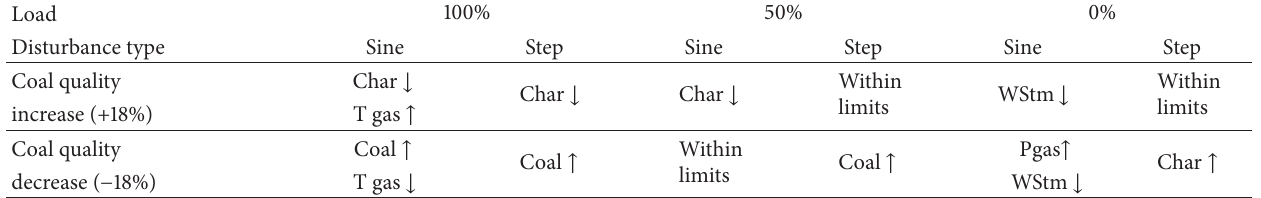
Table 7: Violation variables under coal quality change ( ± 18%) ( ↑ : the variable reaches its upper limit; ↓ : the variable reaches its lower limit). Load 100% 50% 0%